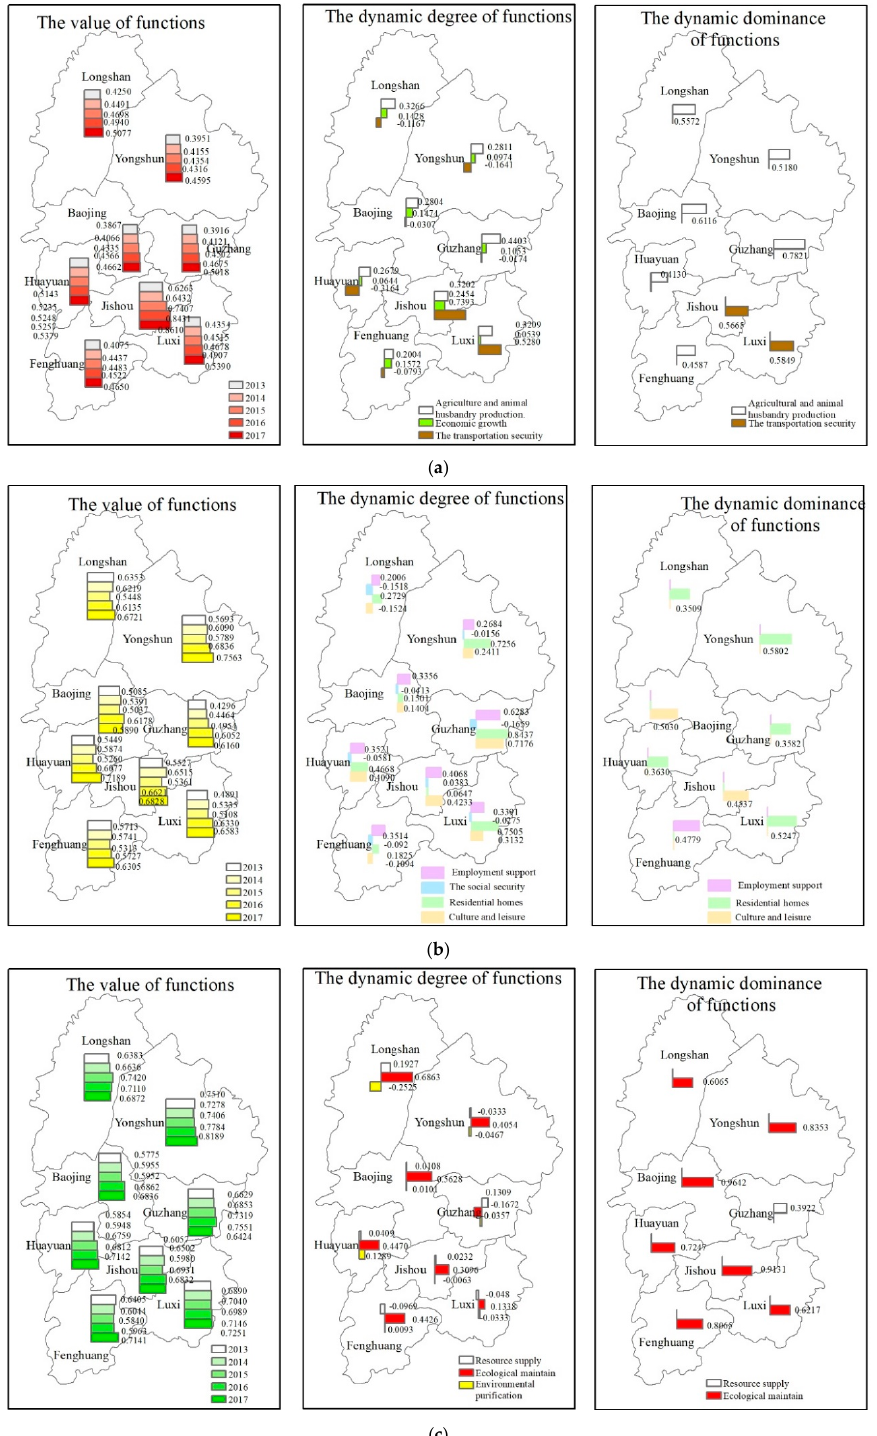
Figure 3. Changes in land use sub-function from 2013 to 2017 in Xiangxi. ( a ) Production functions. ( b ) Living functions. ( c ) Ecological